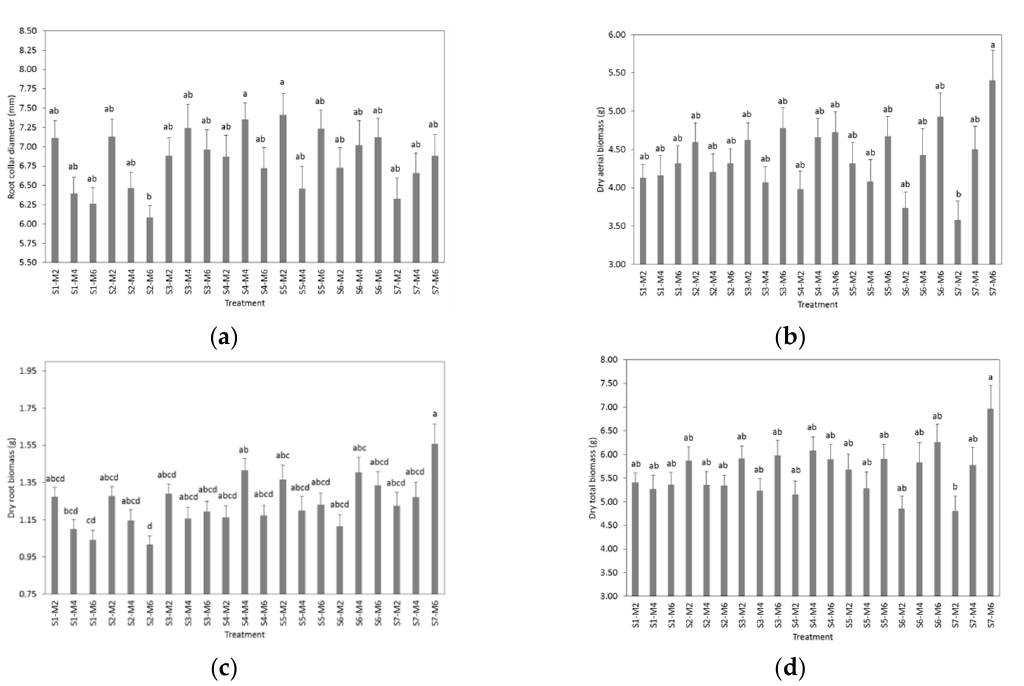
Table 4. Means of N, P and K concentrations in foliage of Pinus engelmannii .